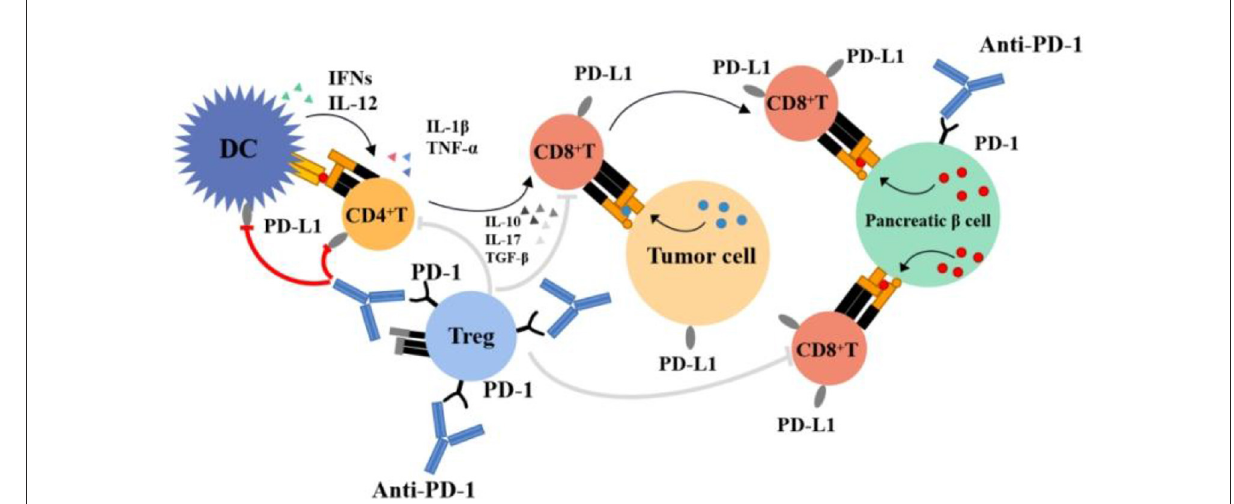
FIGURE2 Pathophysiology of PD-1 Inhibitor–associated Type 1 Diabetes. Treg, regulatory T cells.